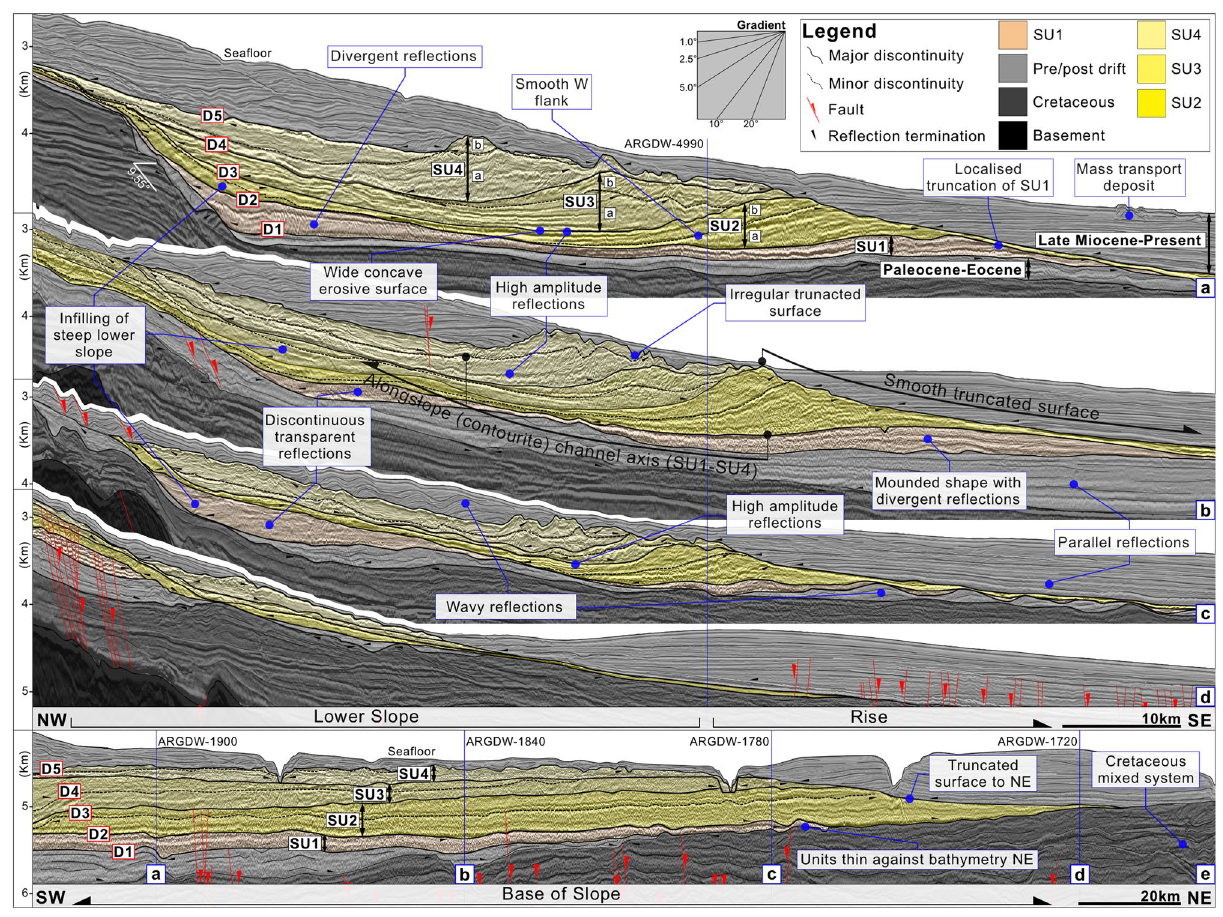
Figure 2. Interpreted seismic crosslines ( a – d ) and inline ( e ) profiles detailing discontinuities (D1–D5), seismic units (SU1–SU4), and sub-units ( a / b ). The figure was generated using Pixelmator Pro 2.1.3 Coral (https:// www. pixel mator. com/ pro/).